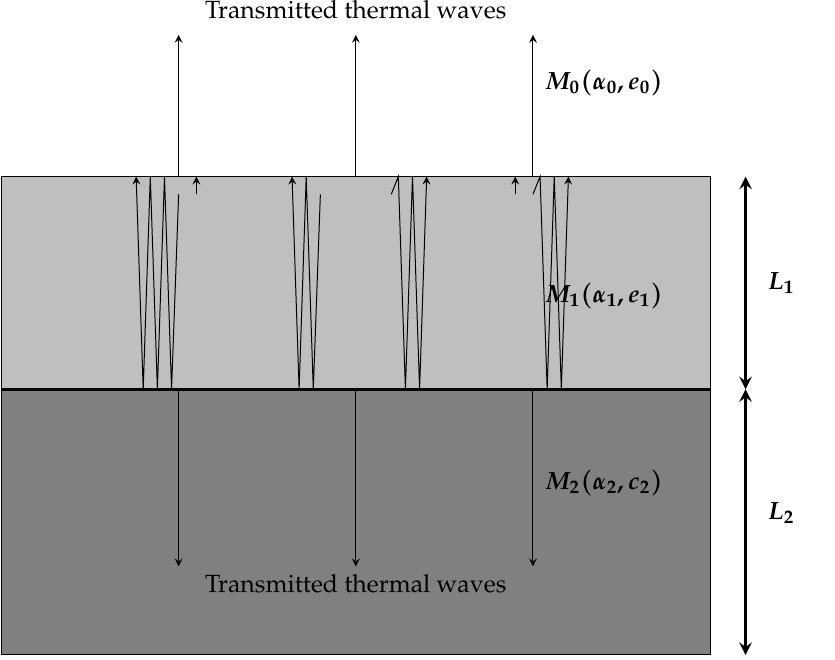
Figure 4. Thermal wave interference in one coating layer on a thermally thick substrate